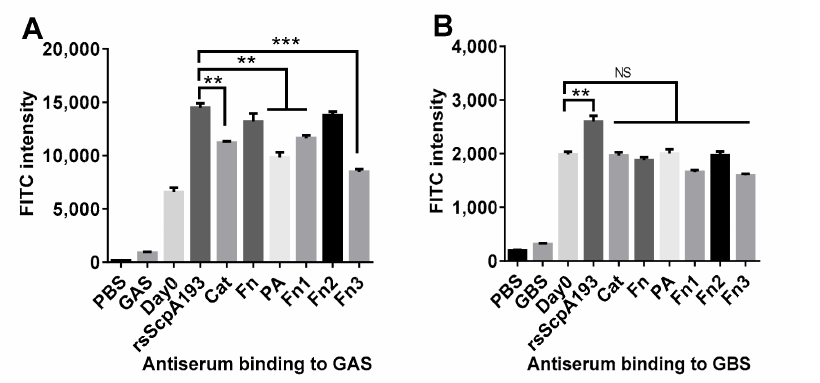
Figure 6. FCM assay of the binding capacities between ( A ) GAS and ( B ) GBS cells and the antis- era (day 56, 1/50 dilution) pooled from mice immunized with segmented domains of ScpA and normal (day 0) mouse sera as negative controls. PBS: phosphate-buffered saline; GAS: S. pyogenes J17A4 (ATCC 12385); GBS: S. agalactiae (ATCC BAA-1138). NS: Not statistically significant; **: Very significantly different ( p < 0.01), ***: Extremely significantly different ( p <